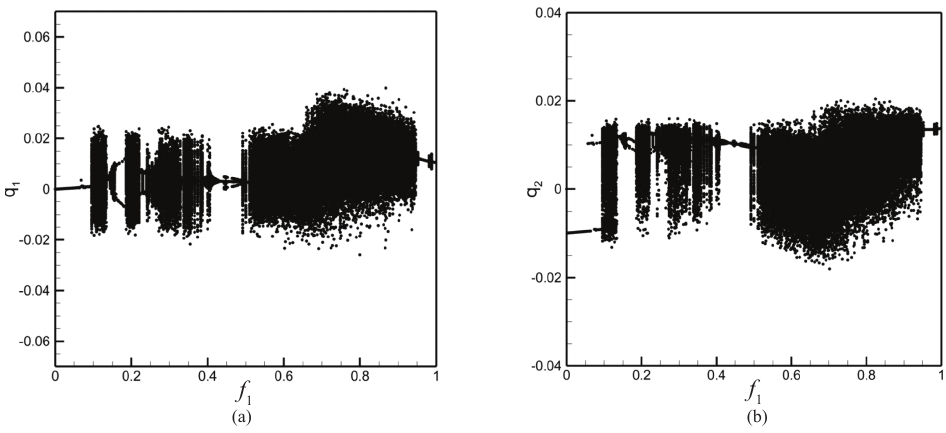
Fig. 14. Bifurcation diagrams of Poincaré points for increasing forcing amplitude on the system with c = 1 . 8 ,α = 10 and β = 2